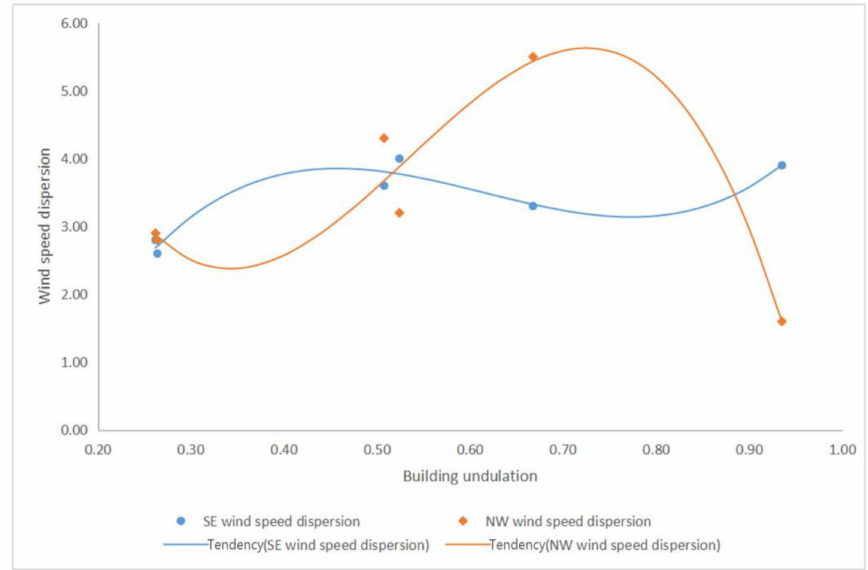
Figure 22. The relationship between wind speed dispersion and building undulation.